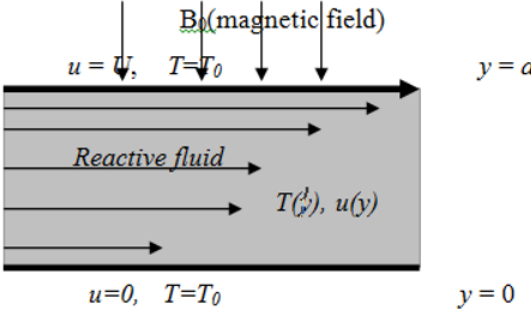
Figure 1. Schematic diagram of the problem